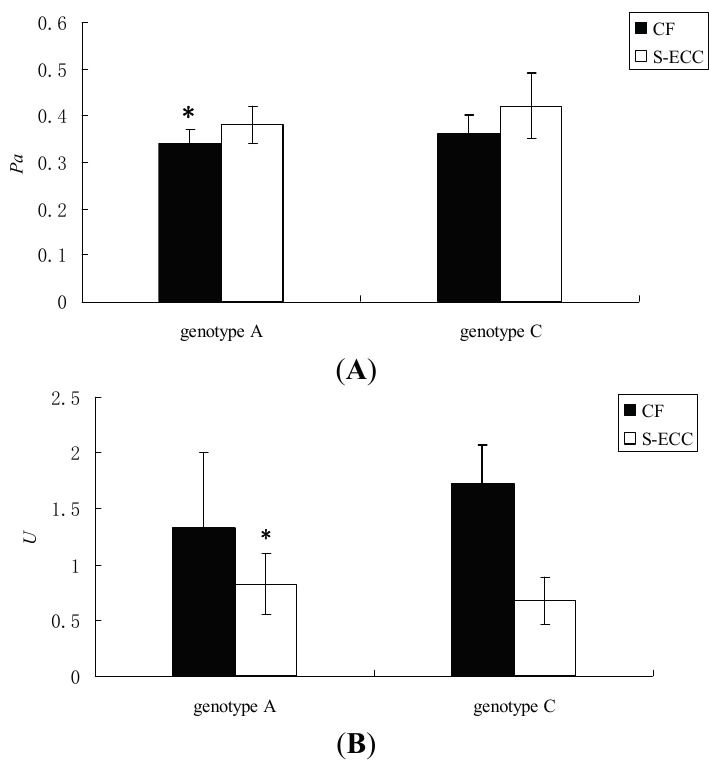
Figure 4. Comparison of the Saps activity in different genotype groups. White bars and black bars represent the means (with standard deviations) of Pa values ( A ) and U values ( B ), which represent the Saps activity of C. albicans from S-ECC and CF children. * denotes statistical significance ( p <